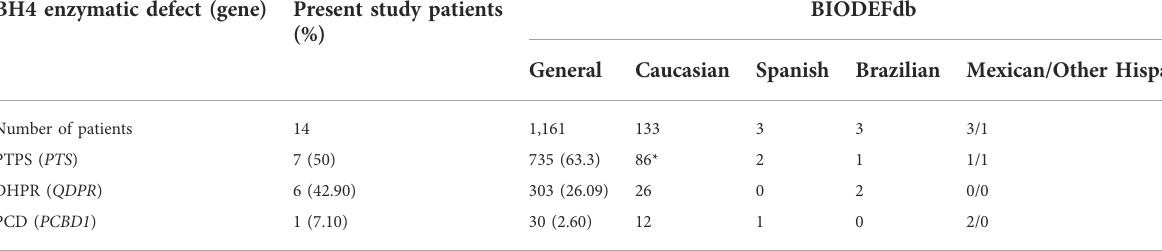
TABLE 2 BH4 defect variants found in the studied Mexican